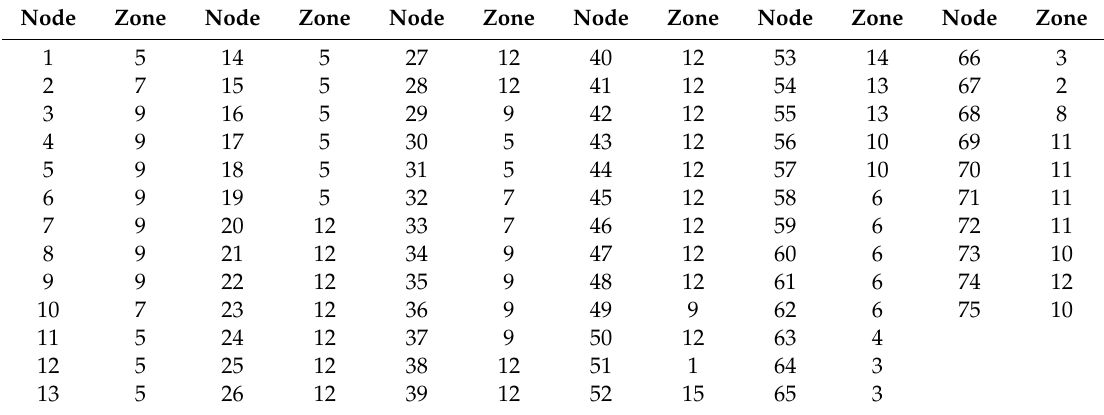
Table 2. List of nodes on the tra ffi c network and their associated zones.